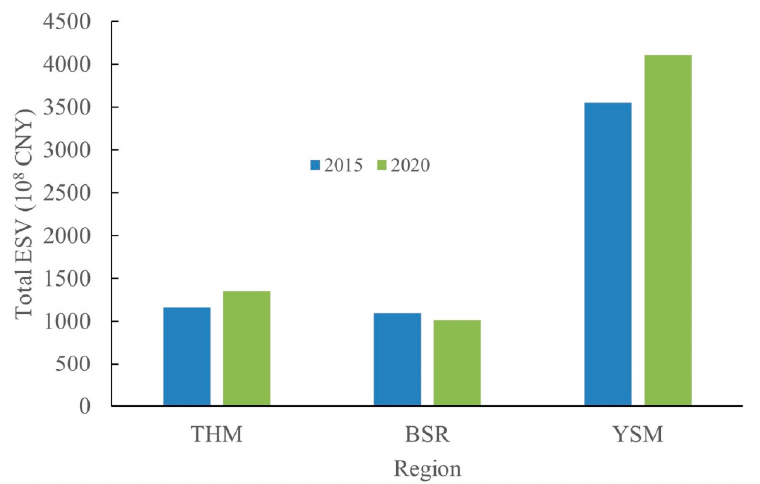
Figure 8. Total ESV of study area at region scale in 2015 and 2020 (THM—Taihang Mountain, BSR—Bashang region, YSM—Yanshan Mountain).